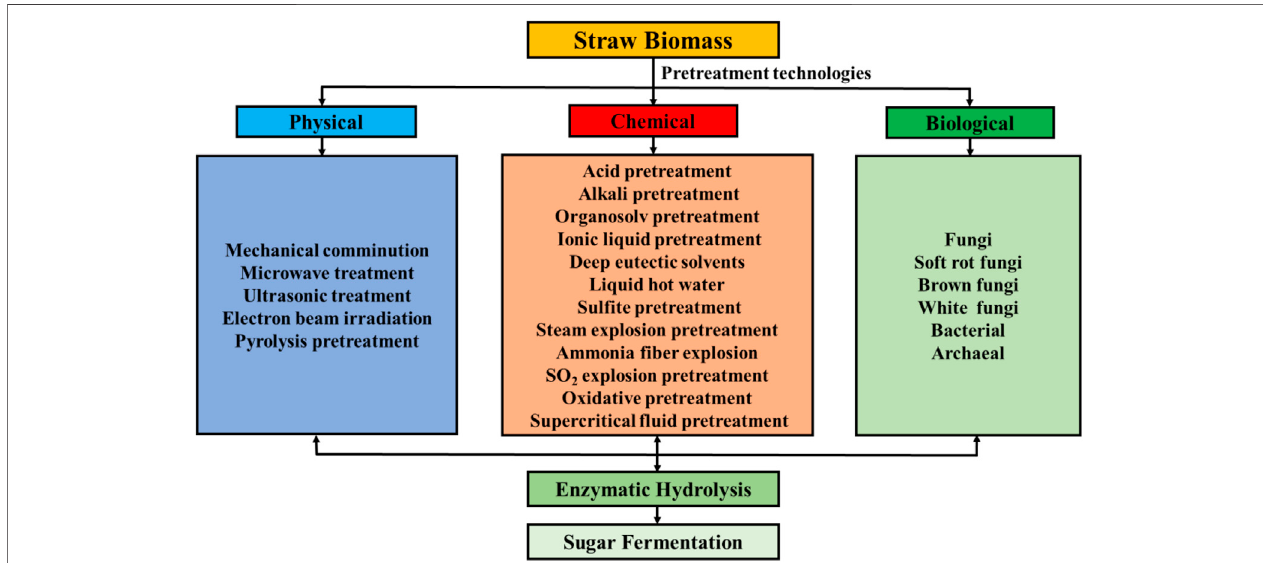
FIGURE 1 | Summary of different methods for pretreatment of lignocellulosic biomass.